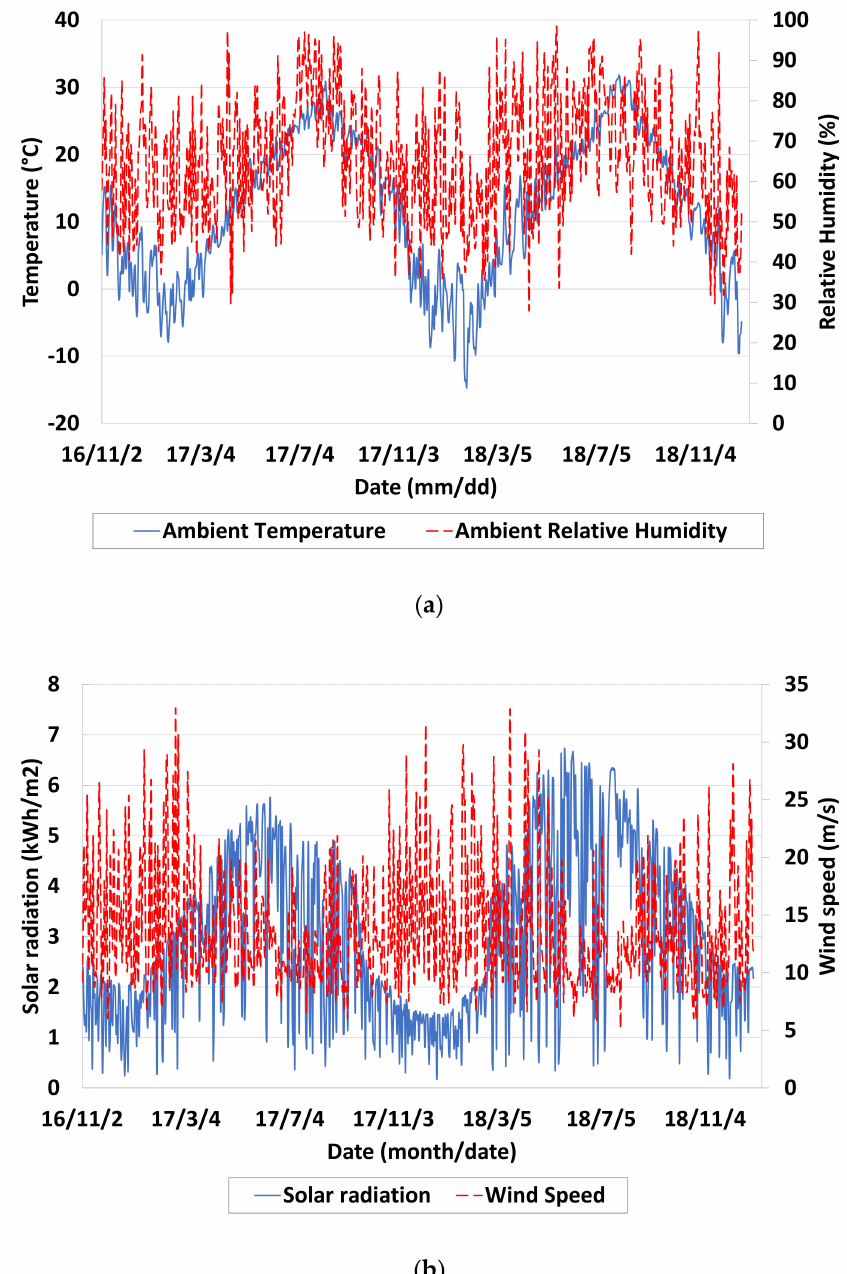
Figure 6. Weather data over a two-year period: ( a ) ambient temperature and ambient relative humidity and ( b ) solar radiation and wind